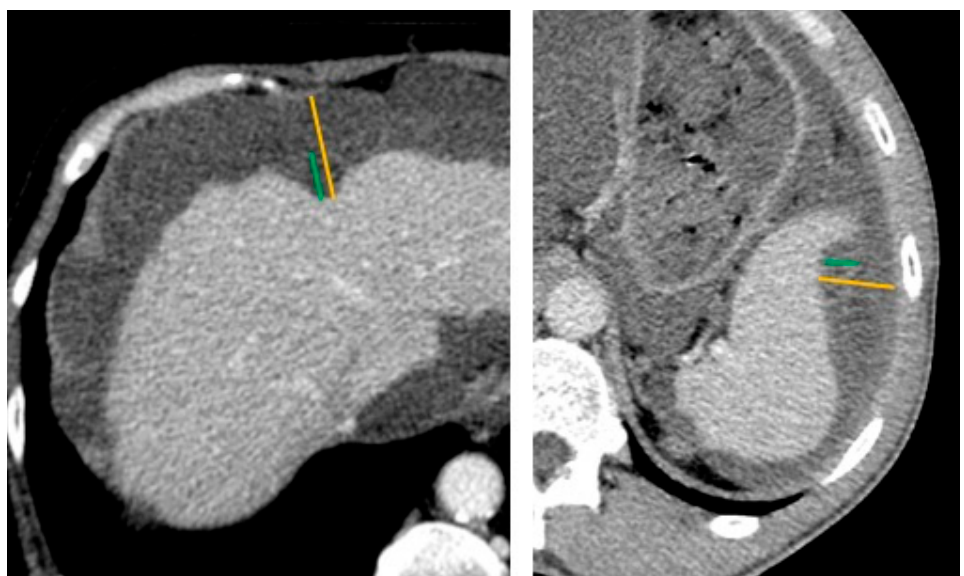
Figure 1. Technique of scalloping measurement on computed tomography scan (CT-scan). Axial contrast-enhanced with a narrow-window CT image showing liver ( left ) and spleen ( right ) scalloping in two patients with pseudomyxoma peritonei. The yellow lines indicate the maximum thickness of mucin deposition up to the diaphragm, and the green lines indicate the maximum thickness of mucin at the expected liver or spleen surface.